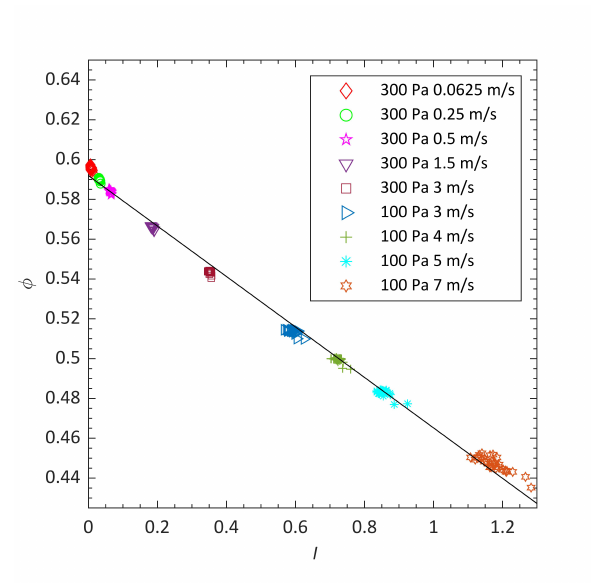
Figure 2. Packing fraction φ plotted against the inertial number I for shear cell simulations run with P w = 300 Pa or P w = 100 Pa and at di ff erent V w values. The line is the fitted Equation